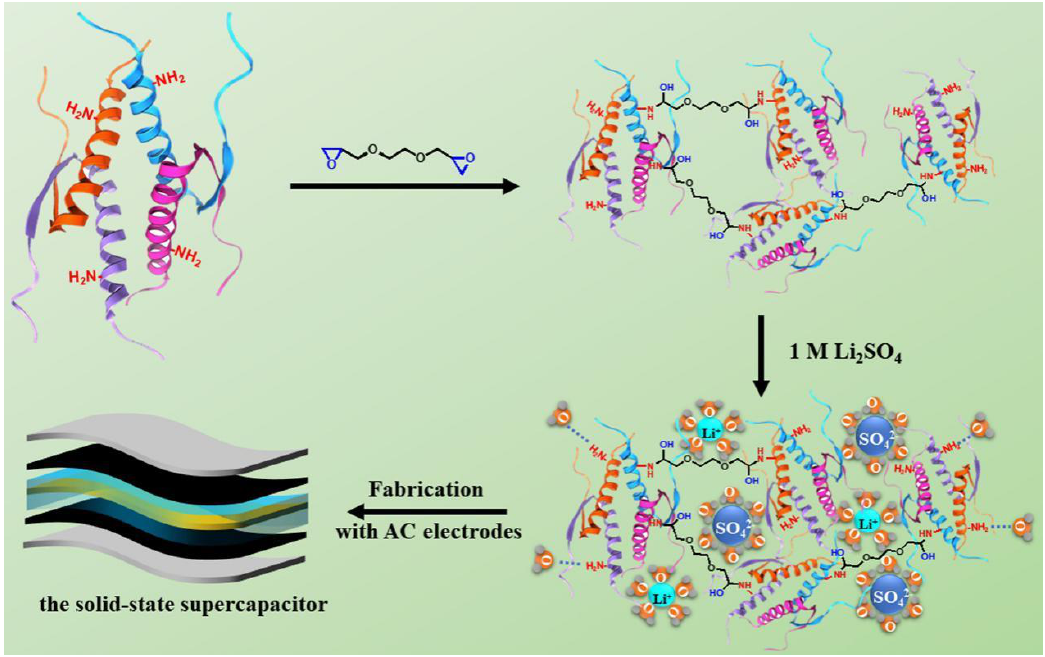
Figure 1. Schematic diagram of the construction process of the gel polymer electrolyte and the solid-state supercapacitor.